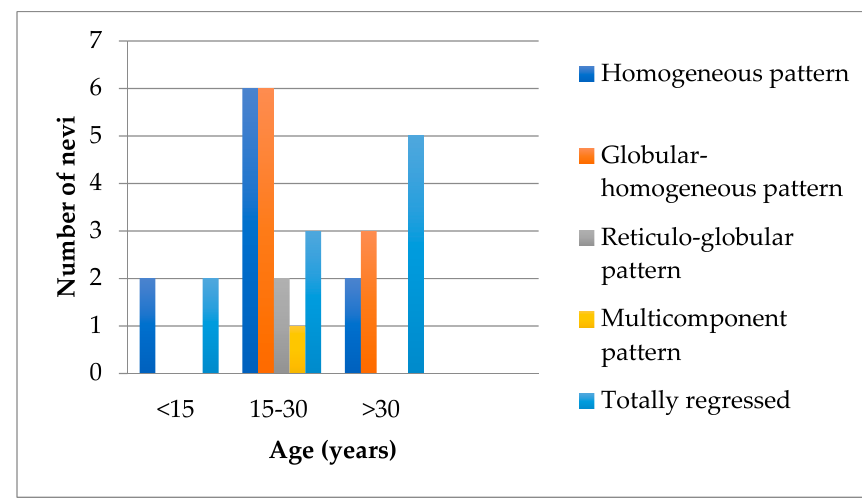
Figure 4. Dermoscopic patterns depending on age